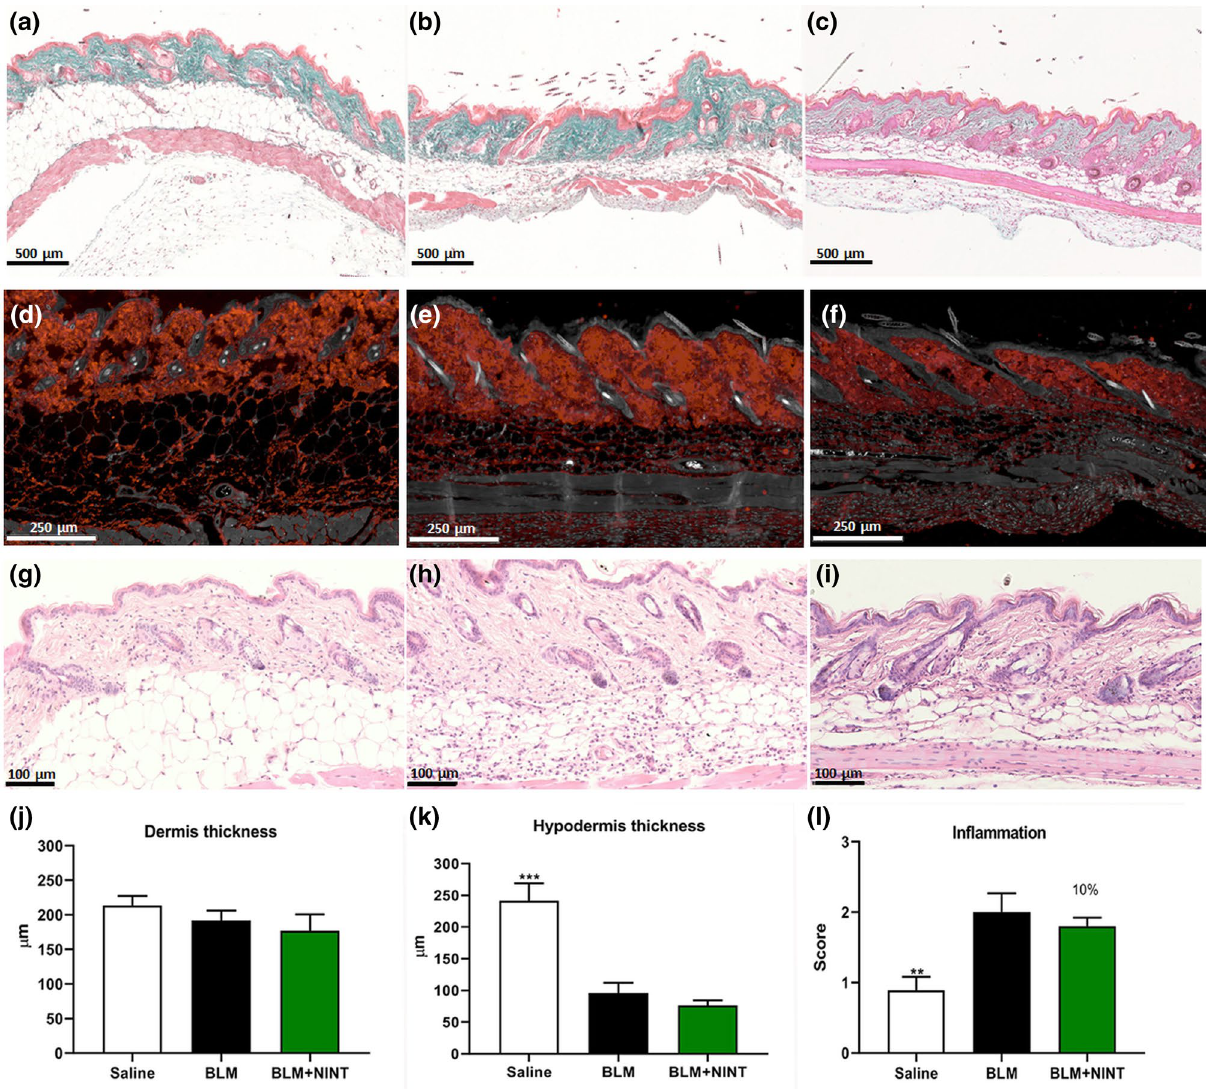
Figure 5. Histomorphometric analysis of skin fibrosis. Evaluation of the antifibrotic activity of nintedanib on bleomycin-induced skin fibrosis through osmotic minipumps at day 28. Skin microphotographs of Saline ( a, d, g ), BLM ( b, e, h ) and BLM + NINT ( c, f, i ) groups. MT stained images ( a, b, c —× 5) showing differences in hypodermis thickness between control and treated animals. Immunofluorescent staining for Collagen Type I ( d, e, f —× 15) showing different levels of expression in control and treated animals. H&E staining ( g, h, i —× 30) showing different inflammatory infiltrates in control and treated animals. Measures of dermis thickness ( j ), hypodermis thickness ( k ) and evaluation of the inflammation score ( i ) were carried out at five randomly selected fields from a sample of each animal. Data are shown as mean values ± S.E.M. for 8 mice per group. Changes were compared to the BLM group using one-way ANOVA followed by Dunnett’s test (**P < 0.01; ***P < 0.001). The percentages on the BLM + NINT bars represent the inhibitory effect of the treatment compared to